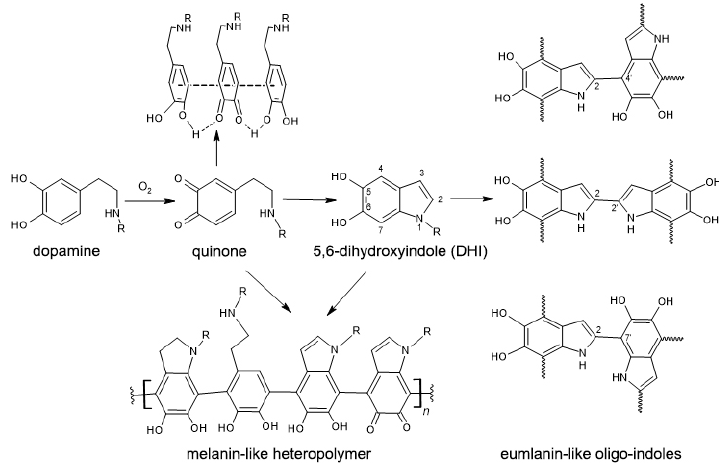
Figure 7. Schematic representation of dopamine polymerization, reproduced from